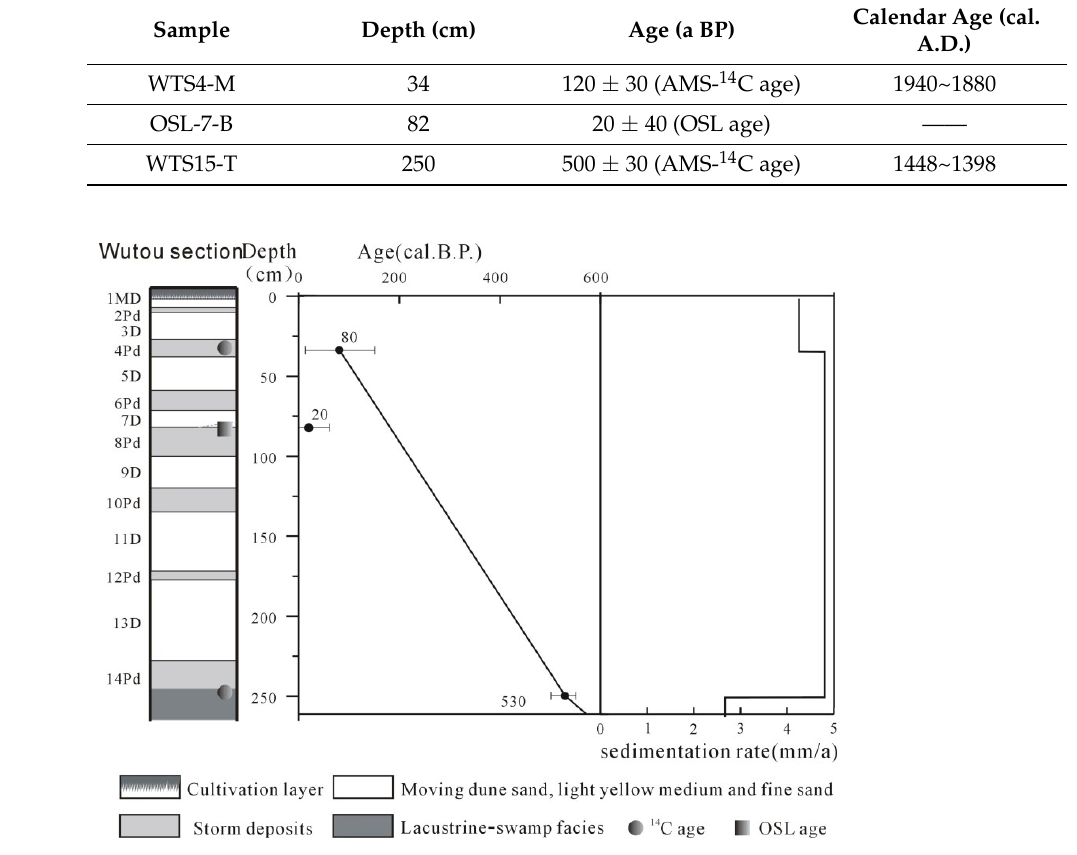
Table 1. Results of optically stimulated luminescence (OSL) and accelerator mass spectrometry (AMS)- 14 C dating for the Wutou section.